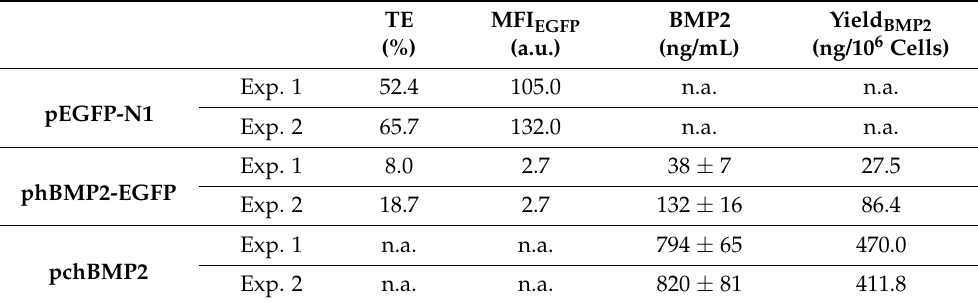
Table 3. Transient transfection of HEK sus cells on micro-scale using different plasmids. TE MFI EGFP BMP2 Yield BMP2 (%) (a.u.) (ng/mL) (ng/10 6 Cells) Exp. 1 52.4 105.0 n.a. n.a. pEGFP-N1 Exp. 2 65.7 132.0 n.a. n.a. Exp. 1 8.0 2.7 38 ± 7 27.5 phBMP2-EGFP Exp. 2 18.7 2.7 132 ± 16 86.4 Exp. 1 n.a. n.a. 794 ± 65 470.0 pchBMP2 Exp. 2 n.a. n.a. 820 ± 81